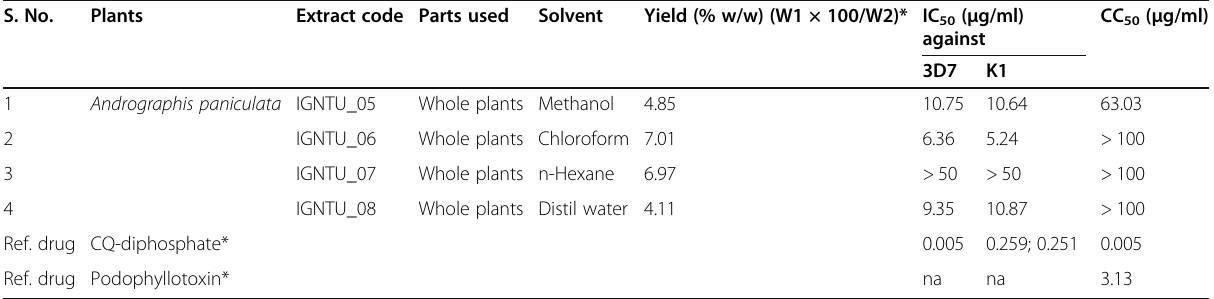
Table 1 Yield analysis, anti-malarial, and cytotoxic activities of Andrographis paniculata whole plant extracts S.